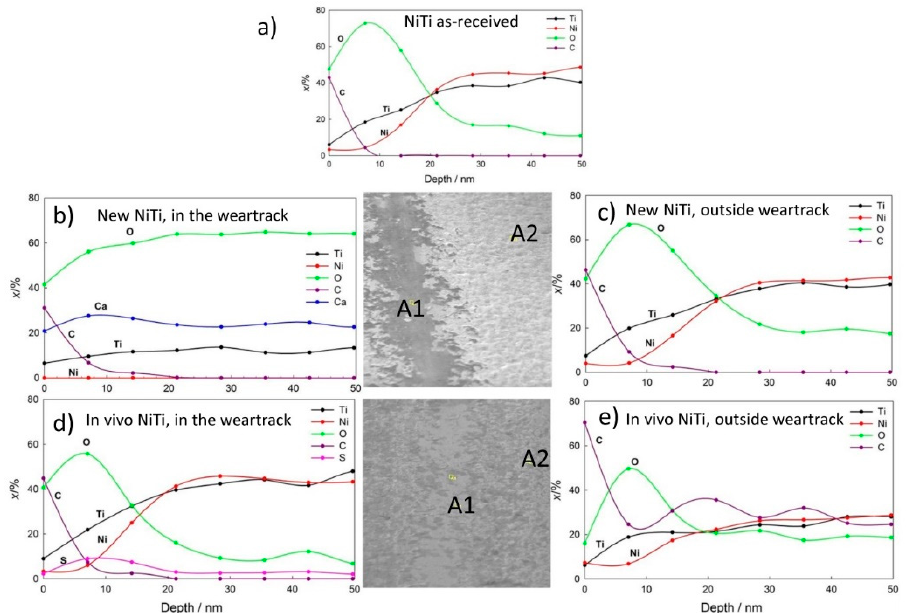
Figure 5. AES depth profiles for as-received NiTi archwire ( a ), NiTi new archwire in the wear track ( b ) and outside the wear track ( c ) and in vivo exposed NiTi archwire after the tribocorrosion experiment, in the wear track ( d ) and outside the wear track ( e ); A1 analysis in the weartrack; A2 analysis outside weartrack. Coatings 2020 , 10 , 230